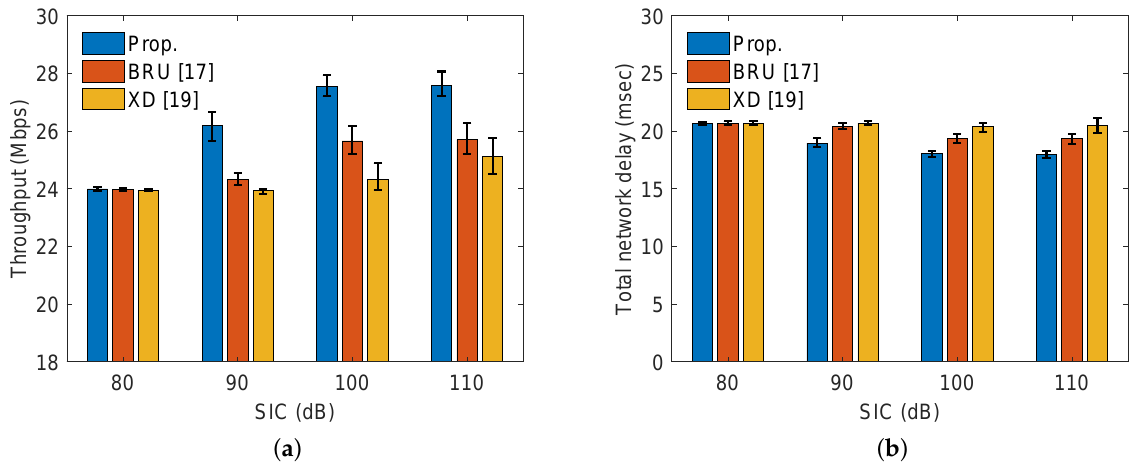
Figure 8. Overall network performance based on SIC ( N = 40) for ( a ) throughput and ( b ) delay. Figure 9 shows MCS probability. FD transmission is almost impossible when SIC = 80 dB, and FD pair probability increases as SIC increases, with high MCS. Hy- brid mode transmission time = 711 µ s for the proposed simulation environment, and FD mode transmission time = 919 µ s and 748 µ s with MCS = 2 and 3, respectively. Thus, the AP operates in hybrid mode when MCS = 2 or 3. In contrast, the AP operates in FD mode when MCS > 4. Simulation results confirm that selecting the transmission mode with respect to the MCS level improves network throughput.